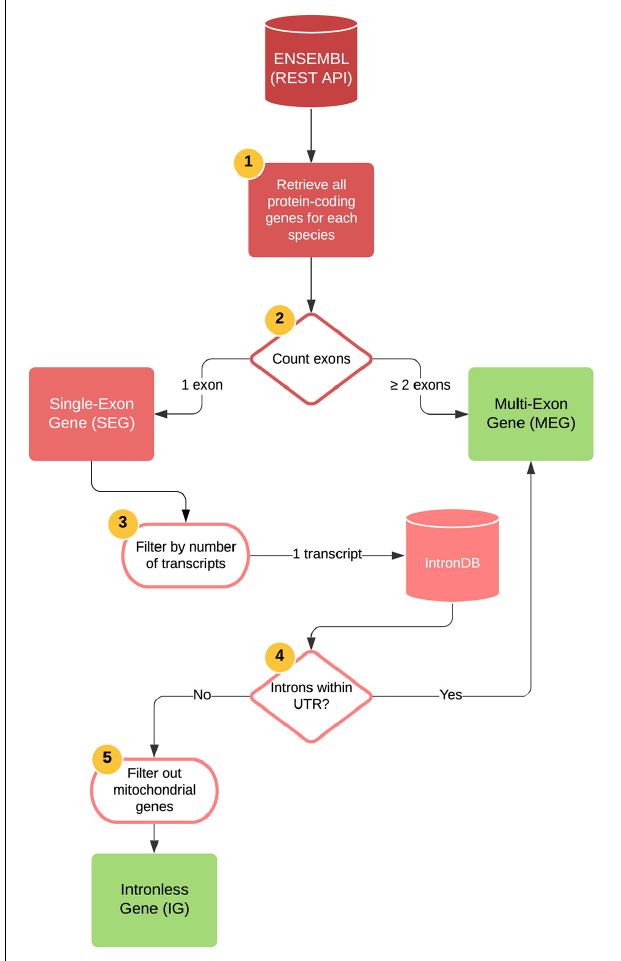
FIGURE 1 | Bioinformatics pipeline for generating IG and MEG datasets. Automatized steps (represented as 1–4): all protein-coding genes were retrieved for each species by accessing the Ensembl REST API platform. The number of exons for each gene were counted, and genes with two or more exons were identified as MEGs. Genes with one single exon were identified as SEGs and were subsequently filtered by their number of transcripts, keeping only those with one transcript. Using the IntronDB, we then classified these genes according to the presence of introns within their UTRs. Genes with introns within these regions were identified as MEGs and those without, as IGs. Manual curation was performed to filter out mitochondrial genes and genes with incomplete protein annotations (step 5). Output files are depicted as green